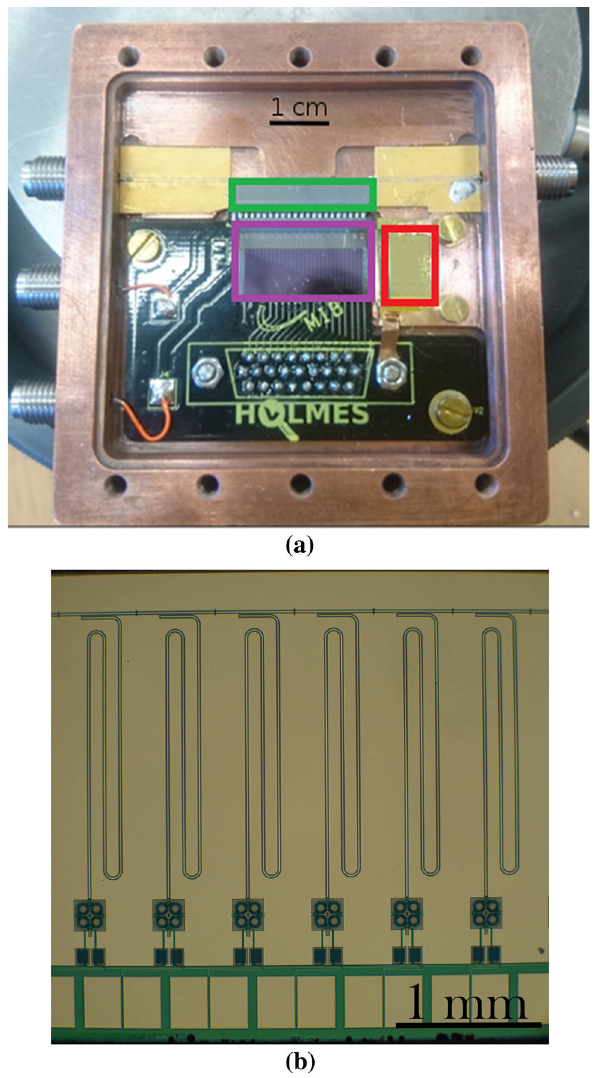
Fig. 3 a Detector holder with the multiplexing (green rectangle), detectors (red) and bias (purple) chip mounted. This last chip is glued on a PCBboard responsible todistribute the biasand rampsignals tothe bias and mux chips, respectively. Atop of the detector chip a collimator is mounted, in order to prevent direct interactions in the TES and in the membrane. b Detail of the mux chip with 6 of the 33 resonators: in the top part of the picture the common feedline running horizontally is vis- ible. The resonant frequency, set by the length of the “trumpet”–shaped transmission line, is designed to be unique for each resonance; at the bottom end of each trumpet the SQUIDs are